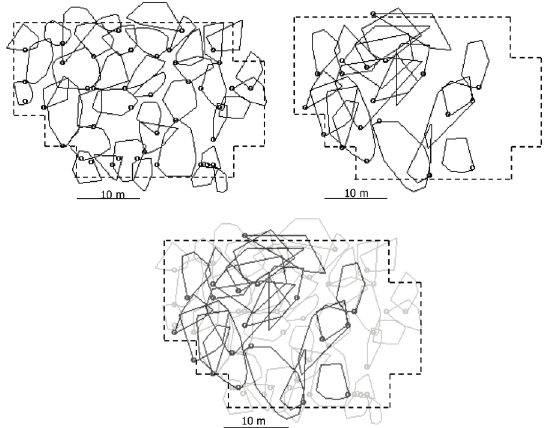
Figure 1 - Spatial distribution of male (upper panel, left, n=40) and female (upper panel, right, n=20) Allobates subfolionidificans individuals in the studied reproductive season in Rio Branco, Acre, Brazil. Lower panel: superposition between male territories (grey) and female home ranges (black). The dashed line indicates the limits of the sampling grid (875 m 2 ).